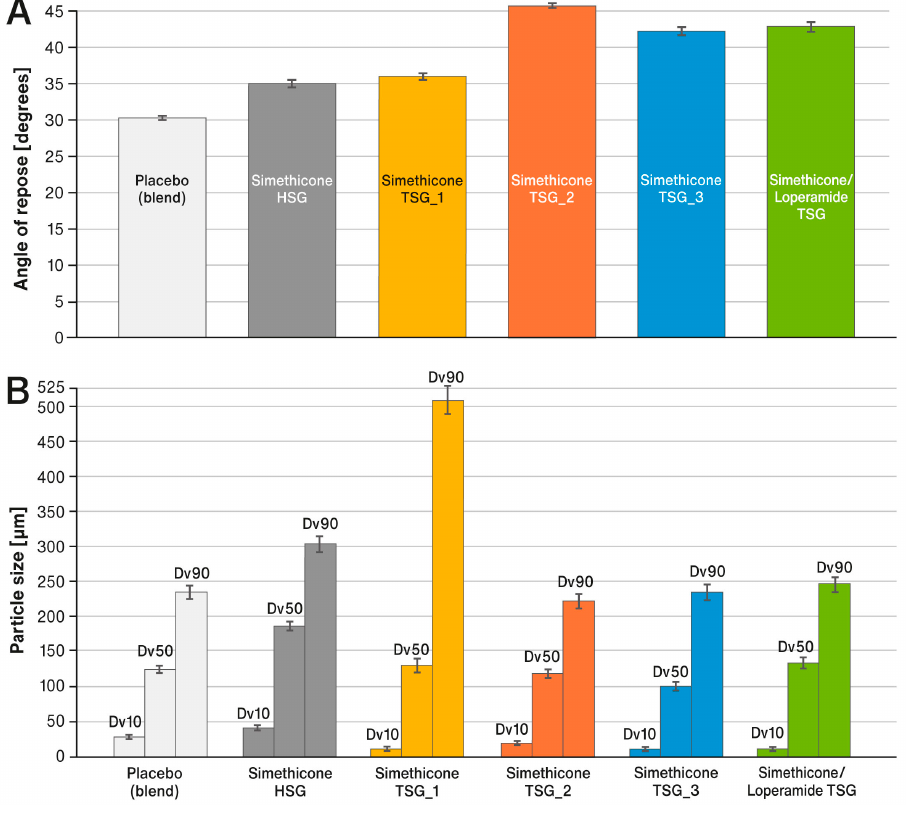
Figure 3. Comparison of ( A ) flow properties (angle of repose) and ( B ) particle size distribution of liquid-loaded powders and placebo blend. Means of n = 3; SD is indicated by the error bars.